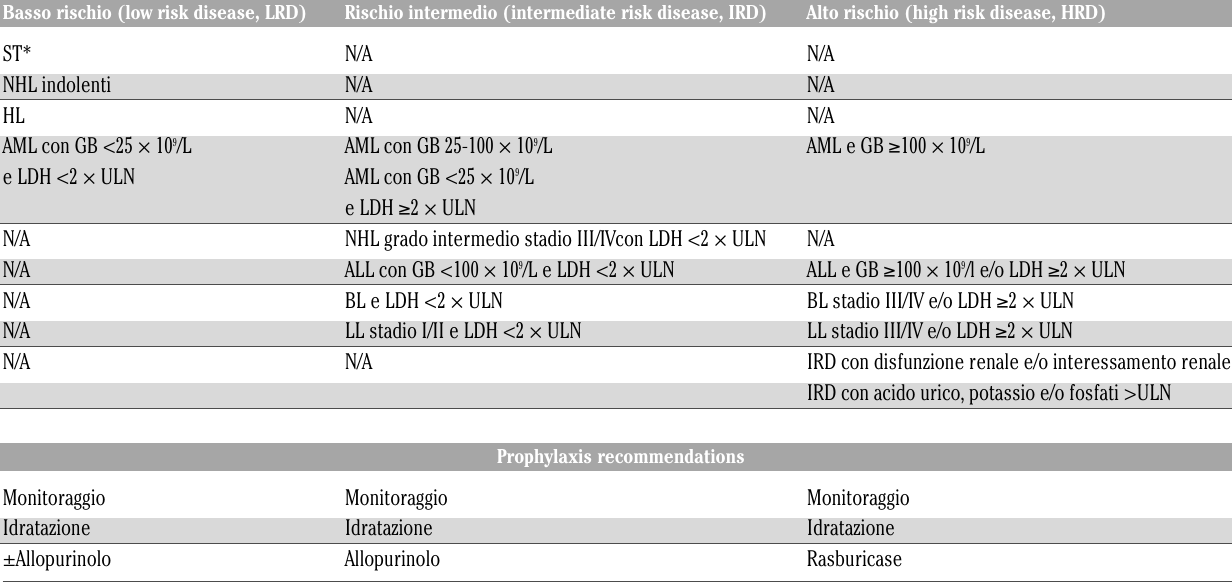
Tabella 3. Startificazione per fascie di rischio e raccomandazioni per la profilassi della TLS in età pediatrica (Modificata da Cairo MS, Coiffier B, Reiter A, Younes A; on behalf of the TLS Expert Panel. Br J Haematol 2010) . Basso rischio (low risk disease, LRD)